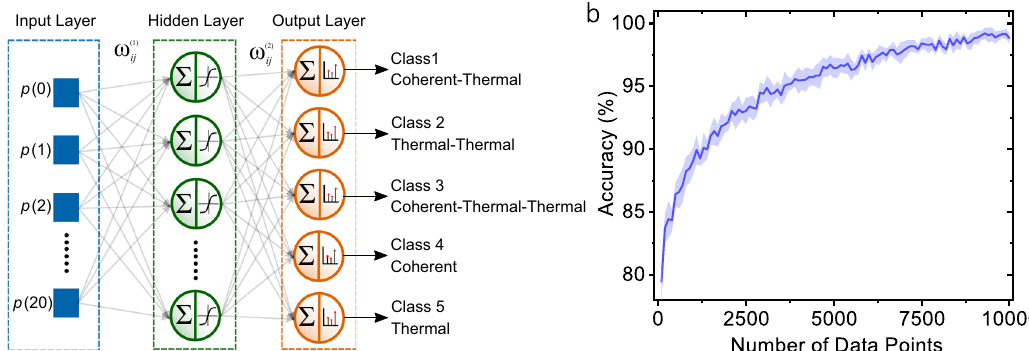
Fig. 2 Arti fi cial neural network design and its performance for superresolving imaging. The scheme of the two-layer neural network used to identify the photon statistics produced by a combination of three sources is shown in a . The computational model consists of an input layer, a hidden layer of sigmoid neurons, and a Softmax output layer. The training of our neural network through Eqs. (2) and (3) enables the ef fi cient identi fi cation of fi ve classes of photon statistics. Each class is characterized by a g (2) function, which is de fi ned by a speci fi c combination of light sources 33 . In our experiment, these classes correspond to the characteristic photon statistics produced by coherent or thermal light sources and their combinations. For example, coherent-thermal, thermal-thermal, or coherent-thermal-thermal. The fi gure in b shows the performance of our neural network as a function of the number of data samples used each time in the testing process. The classi fi cation accuracy for the fi ve possible complex classes of light is 80% with 100 data points. Remarkably, the performance of the neural network increases to approximately 95% when we use 3500 data points in each test sample. The shaded area represents error bars calculated by executing our neural network algorithm 10